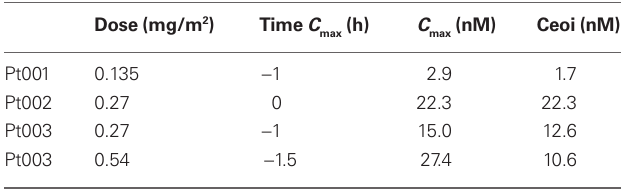
Table 2 | Maximum measured concentrations of Pc 4 ( C concentrations at end of infusion (Ceoi).